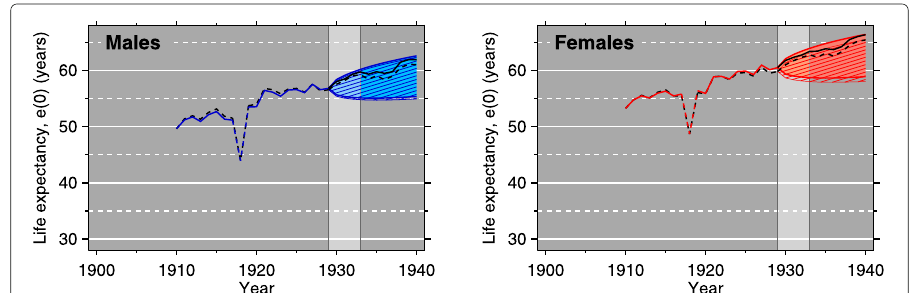
Fig. 8 Same as Fig. 2 (in the main body of the paper), but for death registration states of 1910, only. The year-to-year variance in this figure is not influenced by changes in the composition of the death registration area (unlike Fig. 2). The dashed lines show data for all the death registration states, i.e., the same data and projection as in the main text, except starting in 1910. This is for comparative purposes as well as to